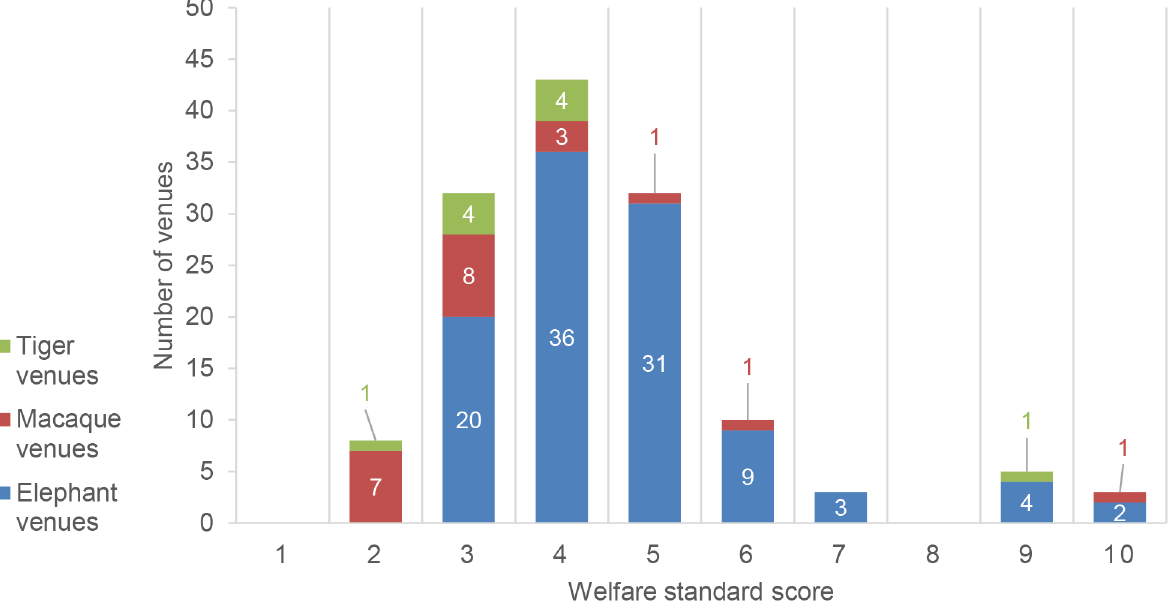
Fig 4. Distribution of venues according to their daytime welfare score (higher score = better welfare). Elephant venues peak around the score of 4, representing inadequate conditions, with a gradual decrease to score 7 and a few venues showing better welfare with highest scores. Macaque venues rated worse with a peak around the score of 3 and a large number of venues even only achieving a score of 2. The few tiger venues fell between scores 3 and 4 with one good exception for a single tiger. The numbers of venues keeping tigers, elephants or macaques were plotted according to the animal welfare score calculated by this study for each venue.